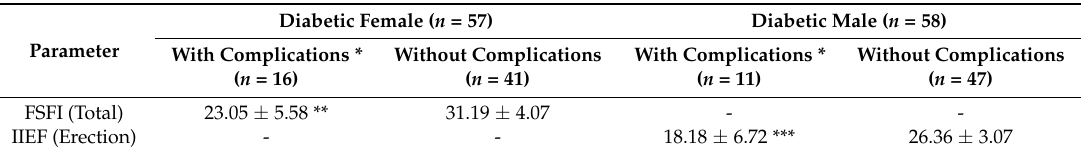
Table 4. Values of the Female Sexual Function Index (FSFI) and the International Index of Erectile Function (IIEF) in diabetic patients with and without complications.